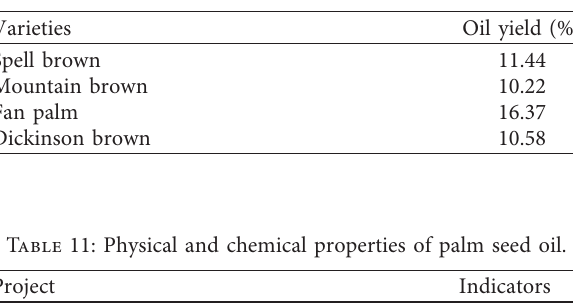
Table 10: Comparison of oil yield results of different varieties of palm seed under optimal technological conditions.